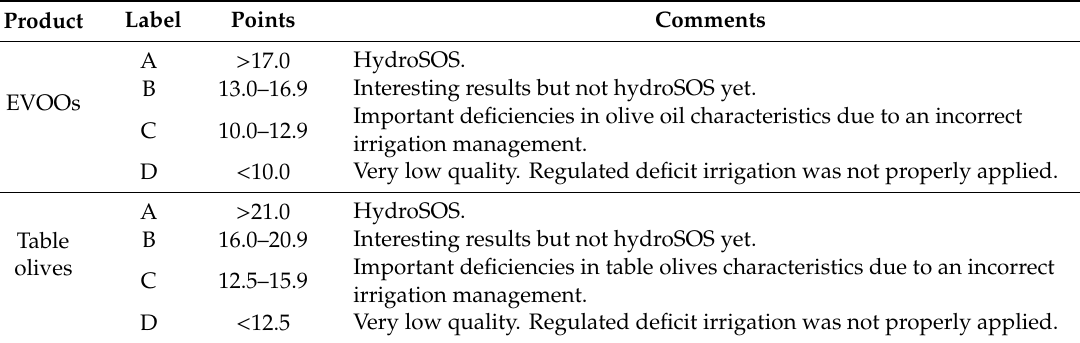
Table 3. Final product indicators, levels, and comments of the hydroSOS quality index in extra virgin olive oils (EVOOs) and table